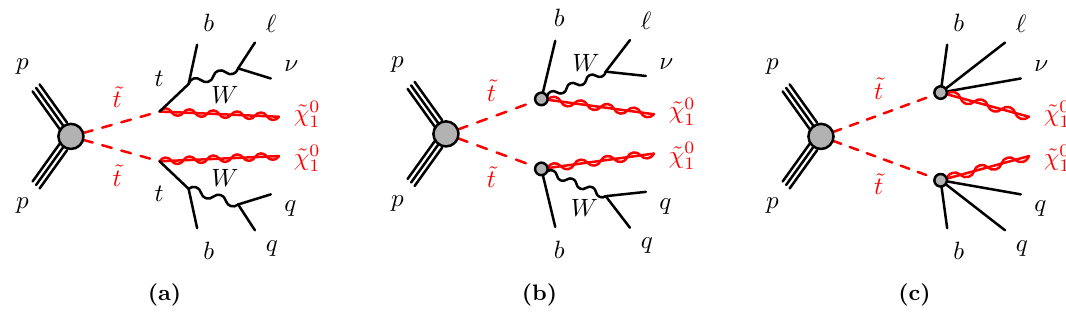
Figure 1. Diagrams illustrating the stop decay modes, which are referred to as (a) ˜ t 1 → t + ˜ χ 0 1 , (b) ˜ t 1 → bW ˜ χ 0 1 and (c) ˜ t 1 → bff 0 ˜ χ 0 1 . In these diagrams, the charge-conjugate symbols are omitted for simplicity. All the processes considered involve the production of a squark-antisquark